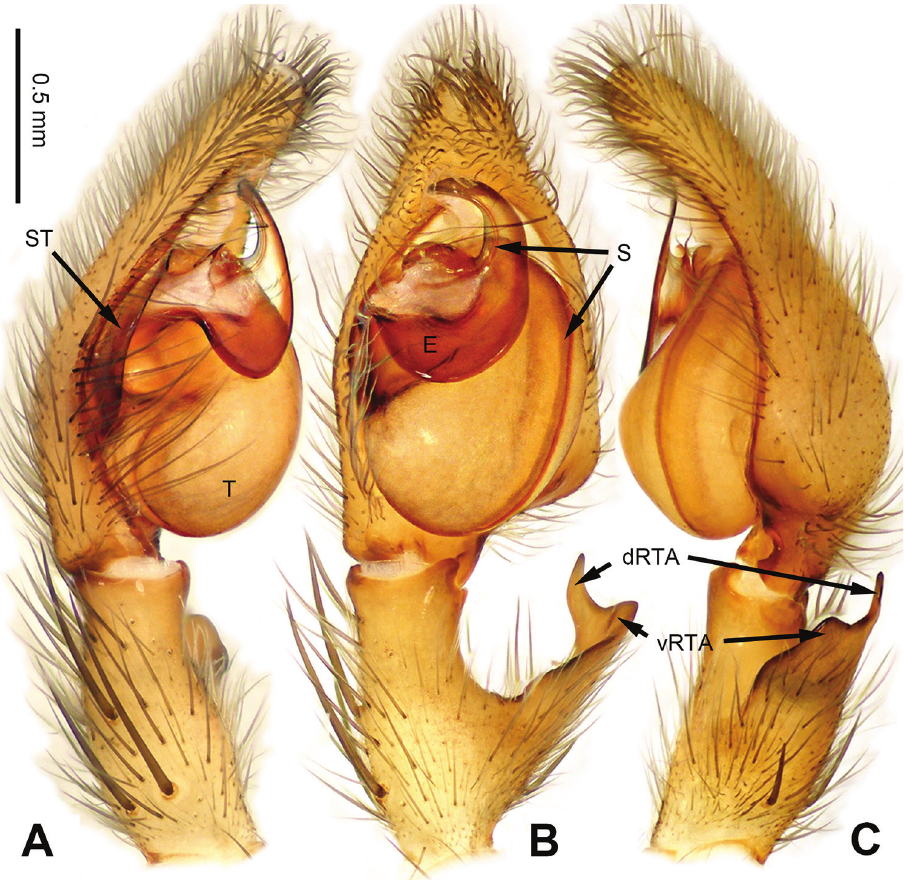
Figure 22. Pseudopoda shuo Zhao & Li, sp. n., right palp of male holotype, horizontally flipped for the sake of comparison. A Prolateral view B Ventral view C Retrolateral view. Scale bar equal for A, B, C